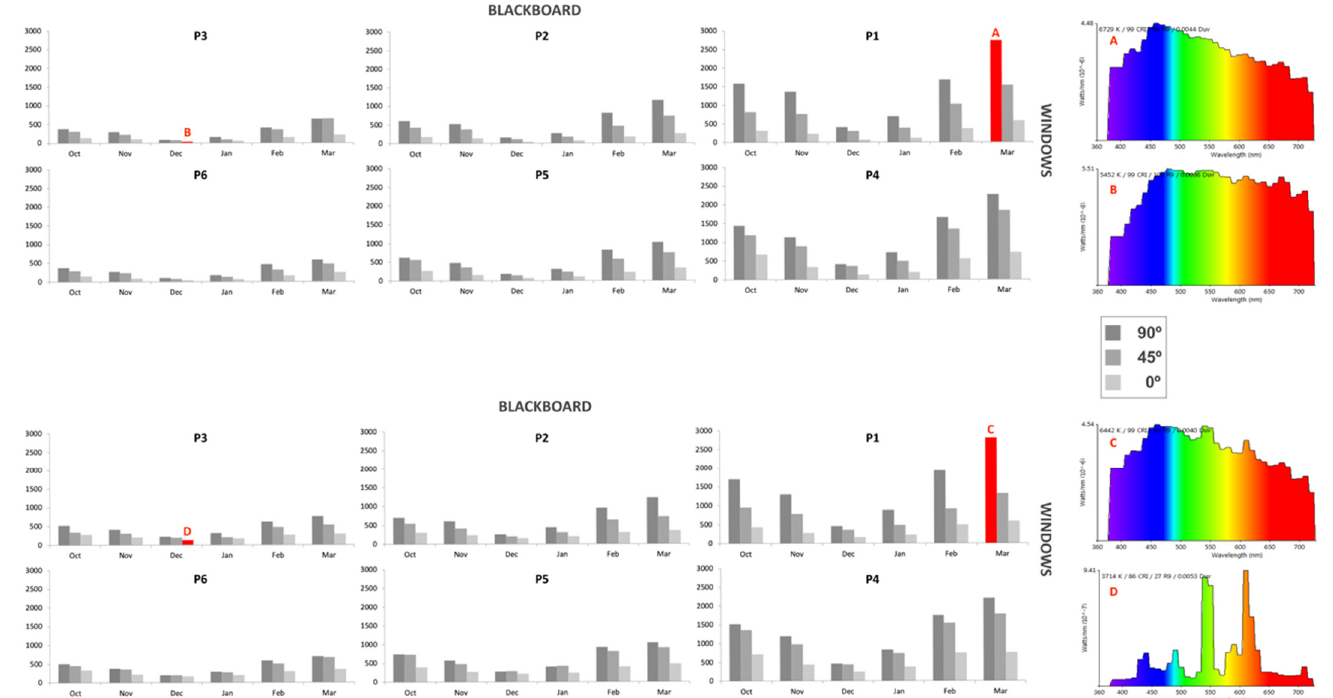
Figure 7. Classroom 4. Melanopic values according to the CIE standard (EDI melanopic lux) acting, in upper figure daylighting in Classroom 4 at each point (P1, P2, P3, P4, P5 and P6) and in the three gaze orientations (0 ◦ , 45 ◦ and 90 ◦ ); in lower figure, daylighting + artificial lighting in Classroom 4 at each point (P1, P2, P3, P4, P5 and P6) and in the three gaze orientations (0 ◦ , 45 ◦ and 90 ◦ ). Right figures, SPD of ( A ) maximum daylighting in the month of March at Point 1 with 90 ◦ orientation; ( B ) minimum daylighting in December at Point 3 with orientation at 0 ◦ ; ( C ) maximum daylighting + artificial lighting in the month of March at Point 1 with 90 ◦ orientation; ( D ) minimum daylighting + artificial lighting in the month of December at Point 3 with orientation at 0 ◦ . OsramColorCalculator was used to plot the